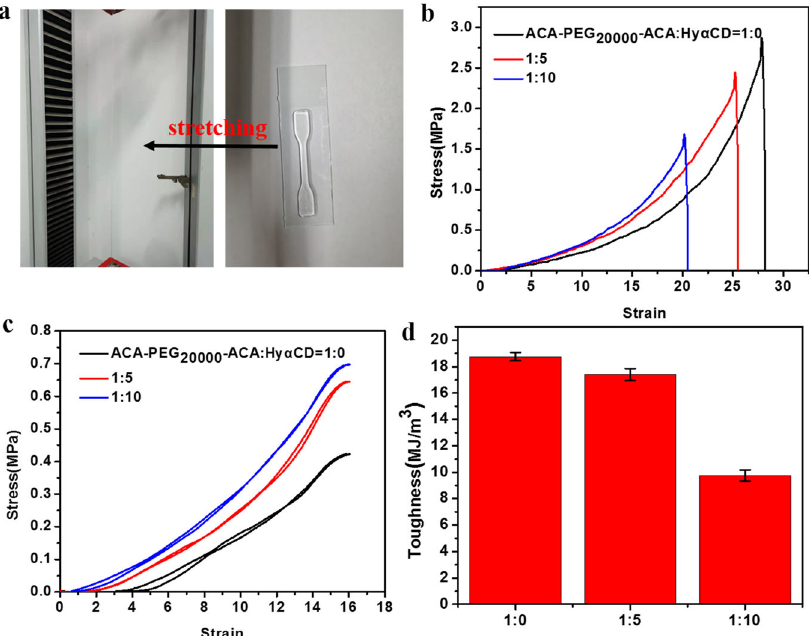
Fig. 4 Tensile properties of hydrogels. a Visual photos used to show the excellent ductility (ACA-PEG 20000 -ACA: Hy- α -CD = 1:5) and Optical photographs of the stretching of the hydrogel. b Tensile stress − strain curves of hydrogels with different polypseudorotaxane components. (black, ACA- PEG 20000 -ACA: Hy- α -CD = 1:0; red, ACA-PEG 20000 -ACA: Hy- α -CD = 1:5; blue, ACA-PEG 20000 -ACA: Hy- α -CD = 1:10). c Tensile loading − unloading curves of hydrogels with different polypseudorotaxane components at strain of 1600% (samples represented by different colors are the same as in Fig. 3c). d Fracture energy of Hy- α -CD/ACA-PEG 20000 -ACA hydrogel with the ACA-PEG 20000 -ACA: Hy- α -CD ratio of 1:0, 1:5 and 1:10.